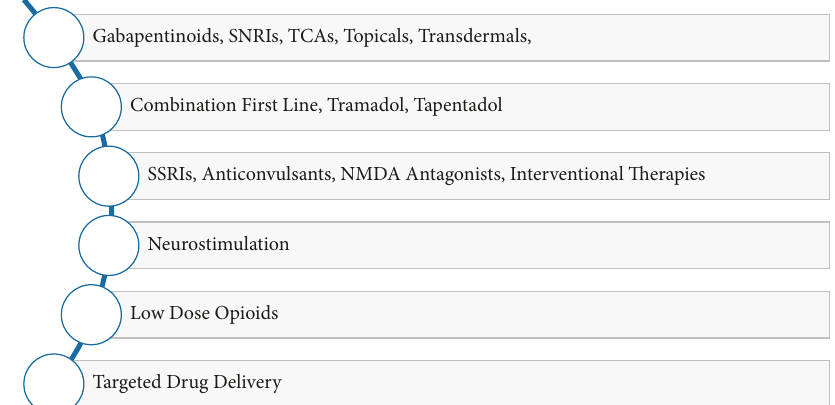
Figure 1: The comprehensive algorithm for the management of chronic neuropathic pain published in 2019.